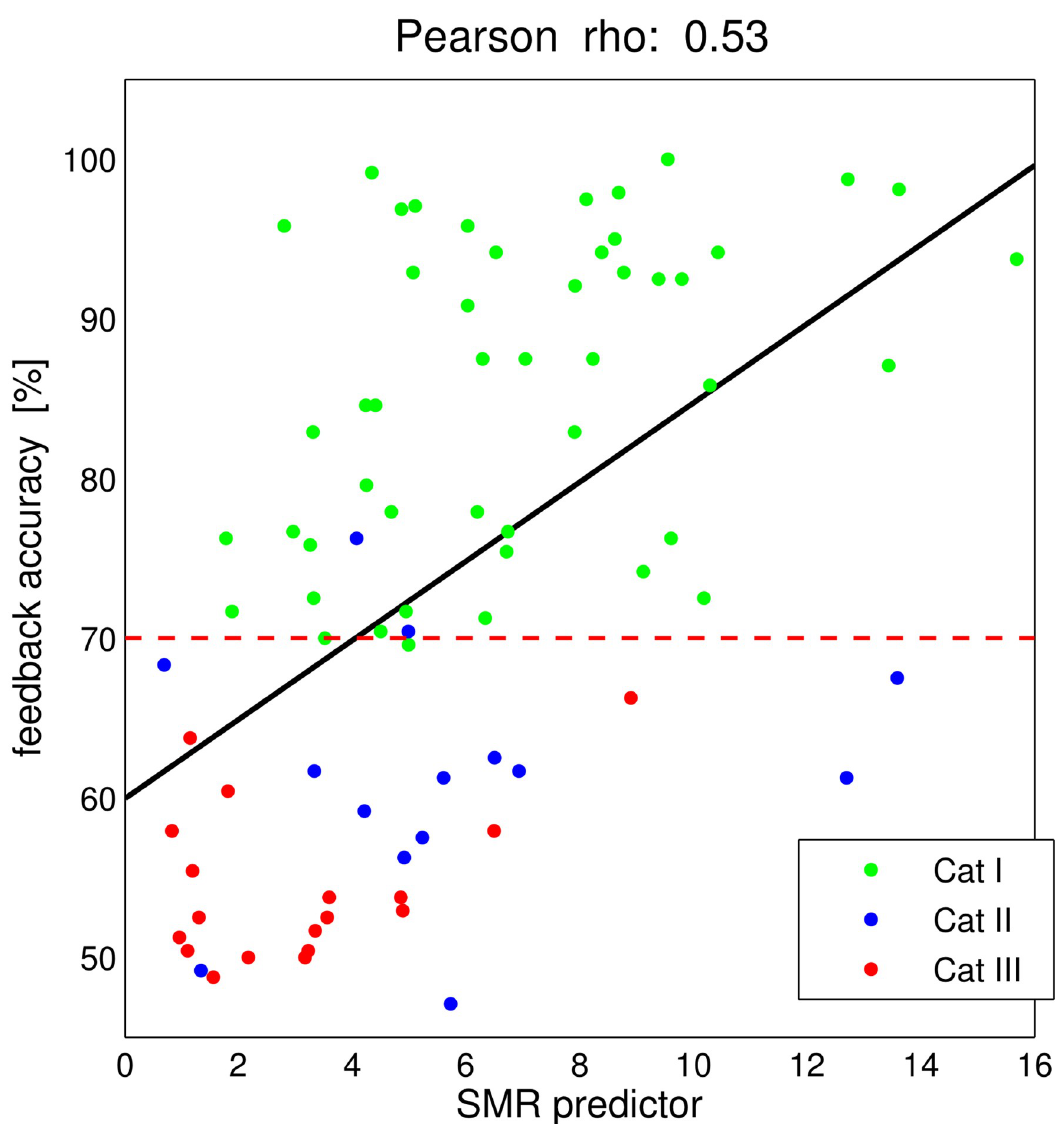
Fig 12. SMR-predictor results. The SMR-predictor is visualized as in [17] with the addition of the user categories. One dot per subject. Linear regression between SMR-predictor values and average feedback accuracy results in the black line. Pearson correlation coefficient r = 0.53. The criterion level of feedback accuracy of 70% is marked by a red dashed